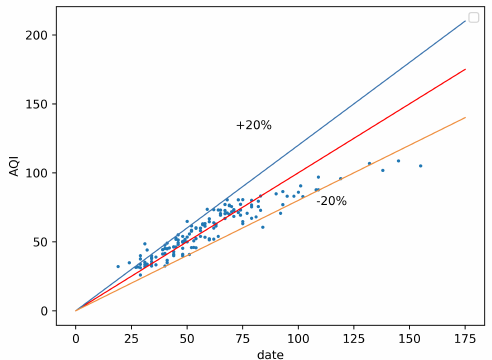
Figure 7. Comparison of predicted and observed AQI values in